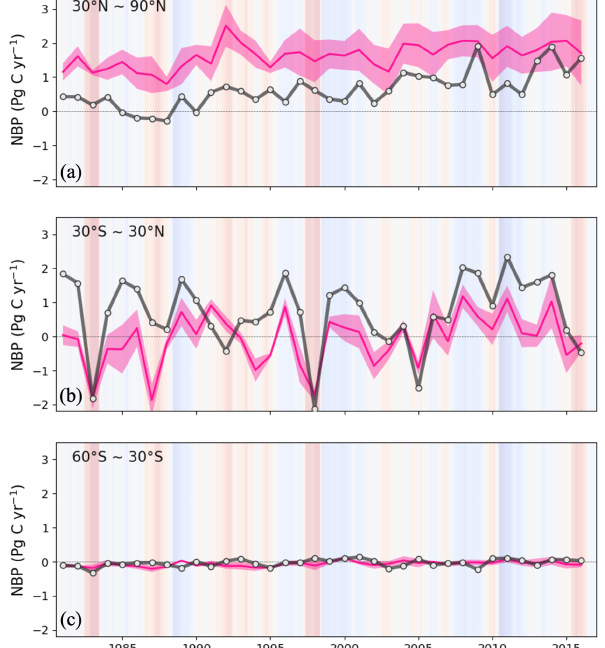
Figure 10. Annual NBP between 1981 and 2016 from ED, and ensemble of atmospheric inversions for the Northern Hemisphere ( > 30 ◦ N) (a) , tropics (30 ◦ N–30 ◦ S) (b) and the Southern Hemi- sphere ( < 30 ◦ S) (c) . Black line is ED and the pink line and pink shading are the inversion ensemble average and the ± 1 σ spread of atmospheric inversions,